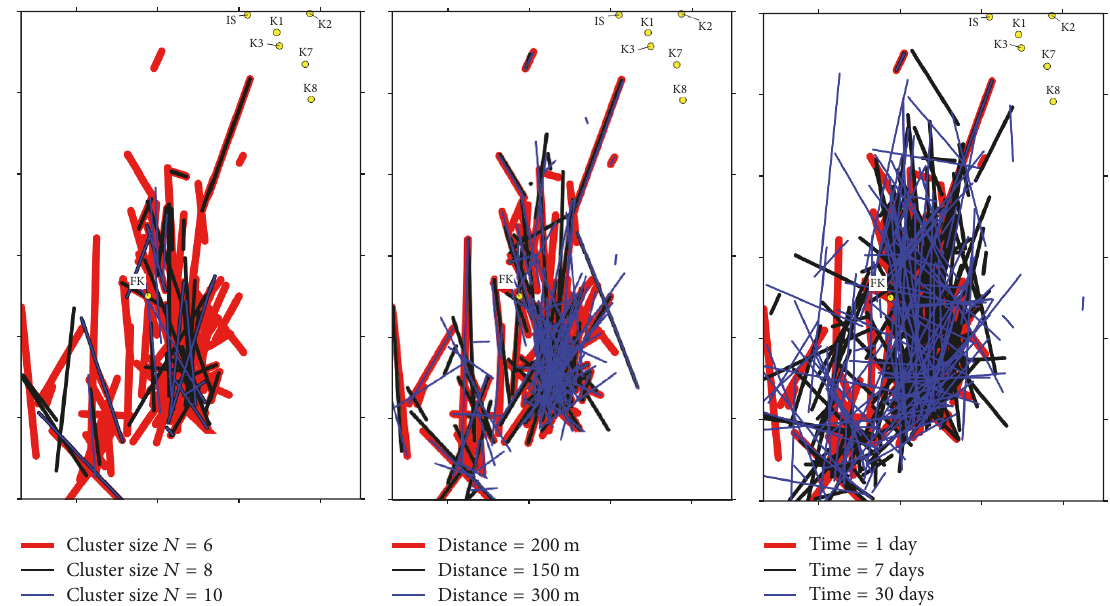
Figure 40: Frac-Digger sensitivity of the estimated dike traces. Dike traces at depths of − 3000 masl below Koryaksky Volcano were estimated using Frac-Digger with different input parameters: cluster size (or the number of events in cluster 𝑁 ), distance from the event to the plane ( 𝛿𝑍 ), and time differences ( 𝛿𝑡 ). The thermal features FK, K1, K2, K7, K8, and IS are given for reference, and the ticks along the axes represent intervals of 2